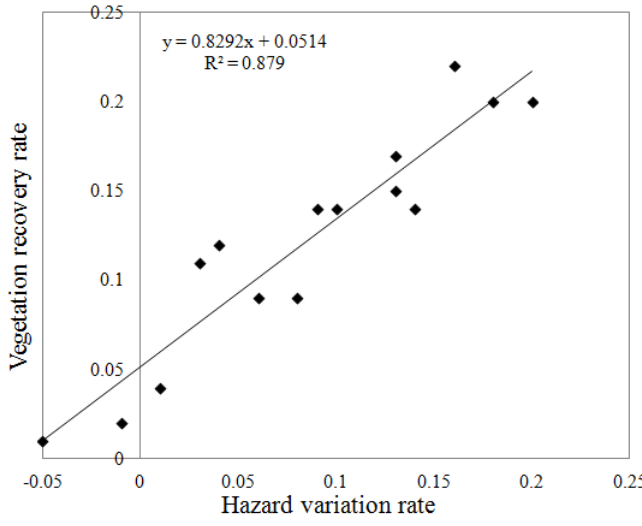
Figure 11. Relationship between vegetation recovery and geological hazards development from 2008 to 2011.